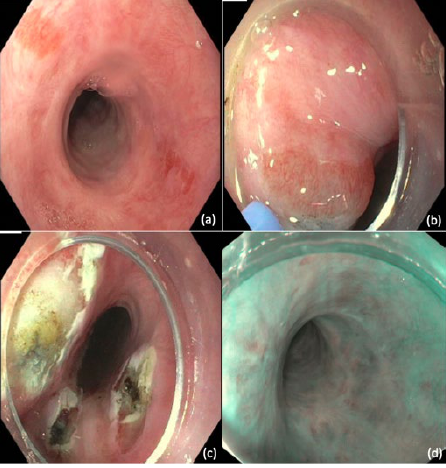
Figure 4. Hybrid argon plasma coagulation (Hybrid-APC). ( a ) Focal islands of Barrett’s esophagus ( b ) Submucosal lift created using a hybrid-APC catheter ( c ) Focal islands after treatment with hybrid-APC ( d ) Neosquamous epithelium identified on narrow band imaging at follow-up endoscopy.